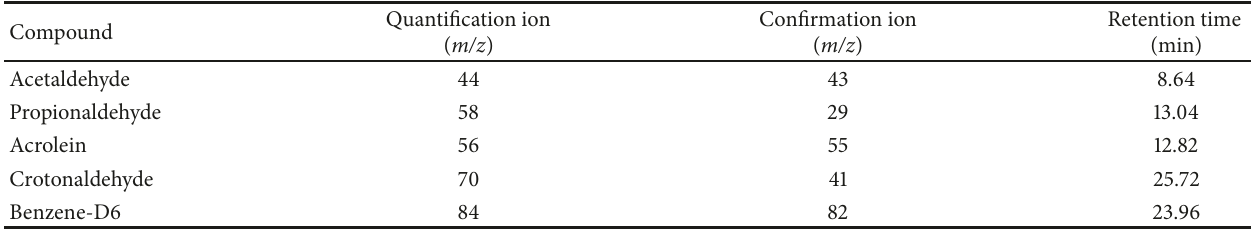
Table 1: Quantitation ions, confirmation ions, and retention times of the target compounds and their isotope internal standards.